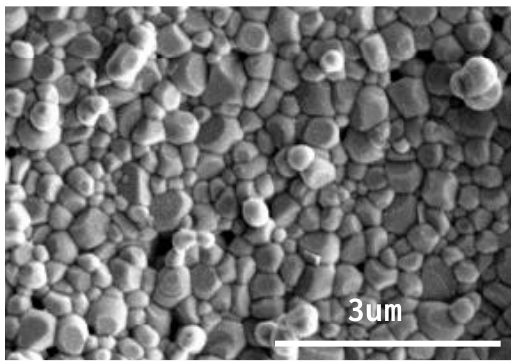
Figure 4. SEM images of CSYG-15%BIT07 sintered at 1300 °C for 5